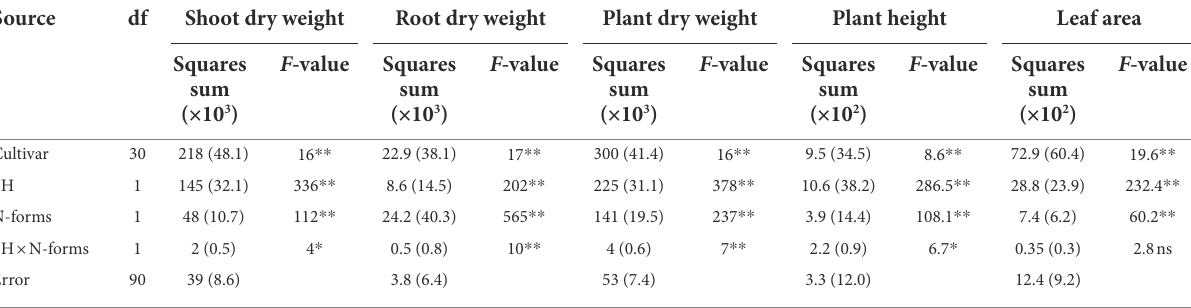
df Shoot dry weight Root dry weight